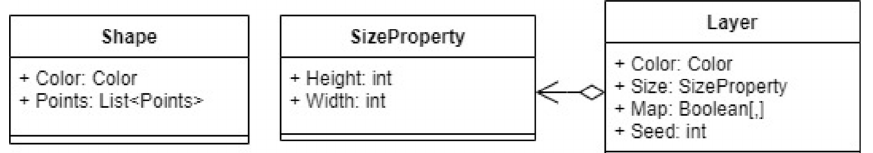
Figure 10. Data layer class diagram of CammoGenerator application.